Question: Reading the figure, is the described quantity rising or falling?
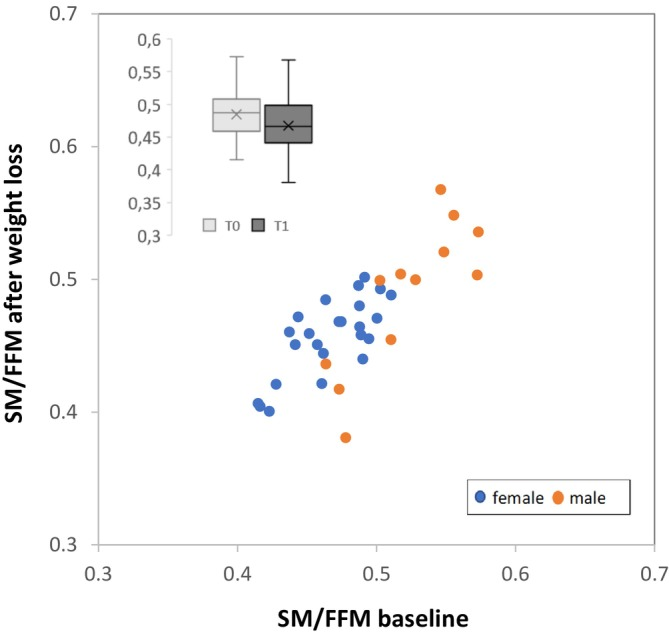
Answer: decreasing